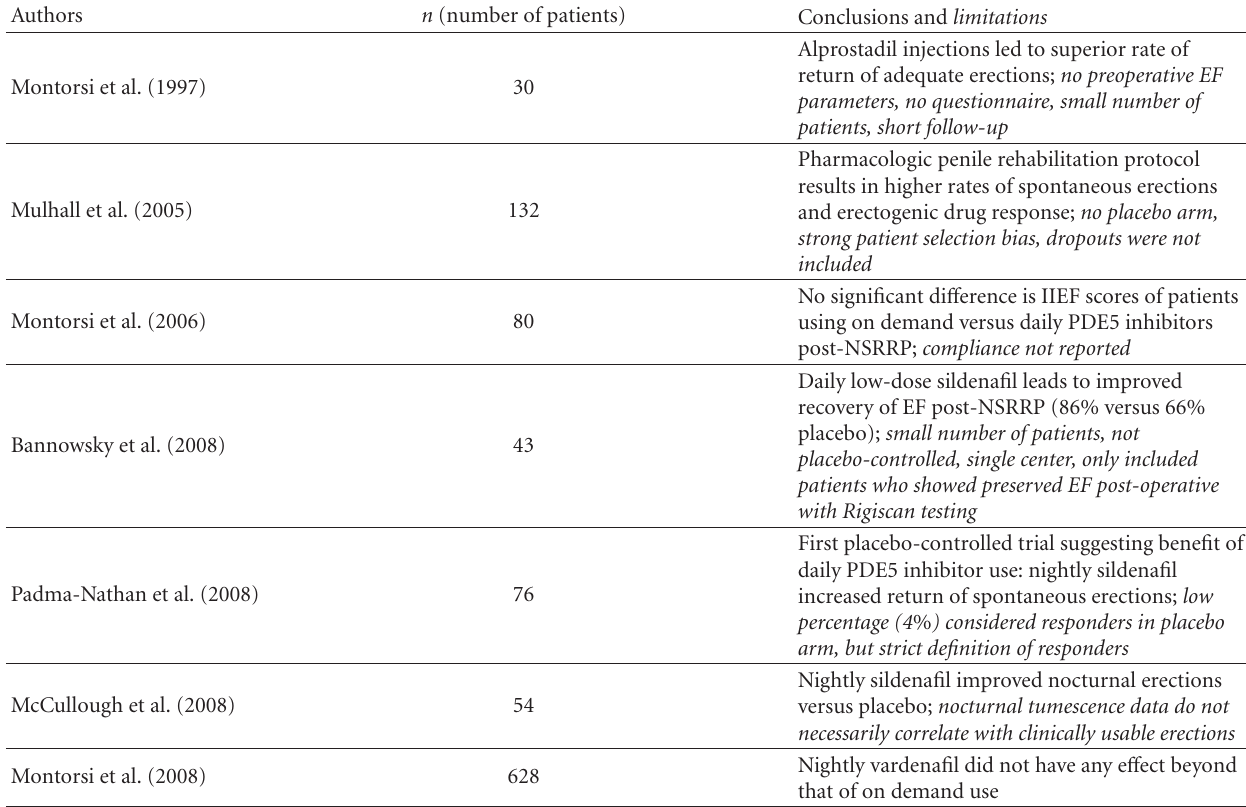
Table 1: Review of clinical